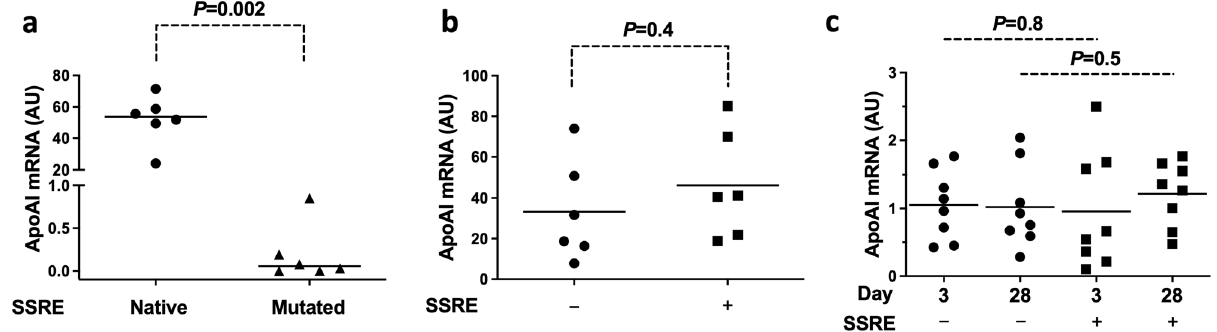
Figure 1. Placement of a shear stress response element (SSRE) upstream of the 4XETE-gApoAI-oPRE expression cassette. ( a ) Bovine aortic endothelial cells (BAEC) were transfected either with a plasmid with the 4XETE-gApoAI-oPRE cassette (including a native SSRE sequence on the “noncoding” stand) or a plasmid in which this SSRE was mutated. ( b ) BAEC were transfected with plasmids either without (−) or with (+) an exogenous SSRE. ( c ) Rabbit carotid endothelial cells were transduced in vivo with HDAd vectors including the 4XETE-gApoAI-oPRE expression cassette either without (−) or with (+) an exogenous SSRE. Carotid arteries were removed on day 3 or 28 after vector infusion and APOAI mRNA was measured by RT-qPCR. ( a , b ) APOAI mRNA was measured by RT-qPCR, 24 h after transfection. Data are from three independent experiments ( a ) or two independent experiments ( b ). Bars are medians ( a ) and means ( b ). ( c ) Data points are individual arteries; bars are